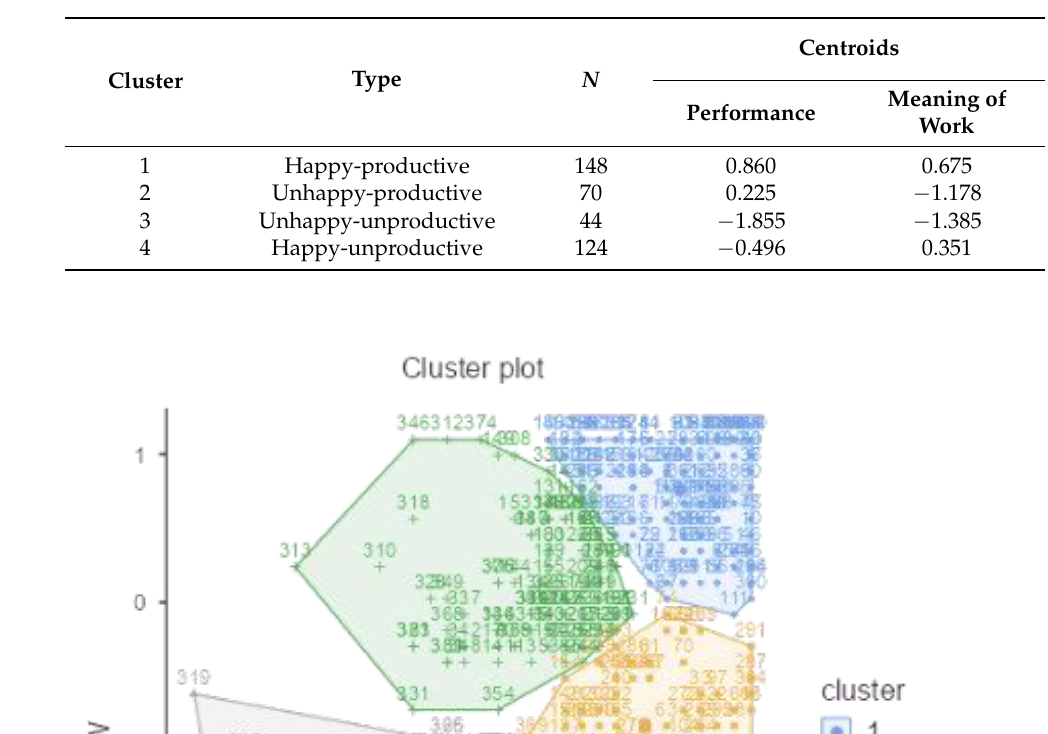
Table 1. Four-cluster solution, cluster standardized means and group-sizes, Meaning of Work and Job Performance (Study 1; N = 386).